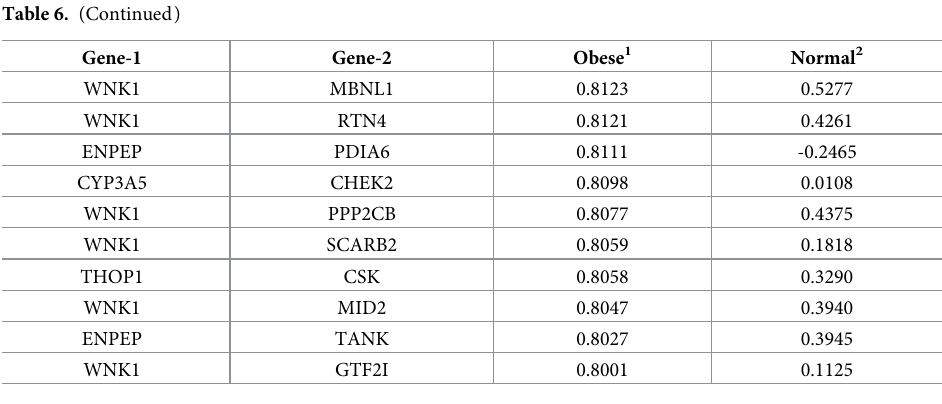
PLOS ONE | https://doi.org/10.1371/journal.pone.0228400 February 6,